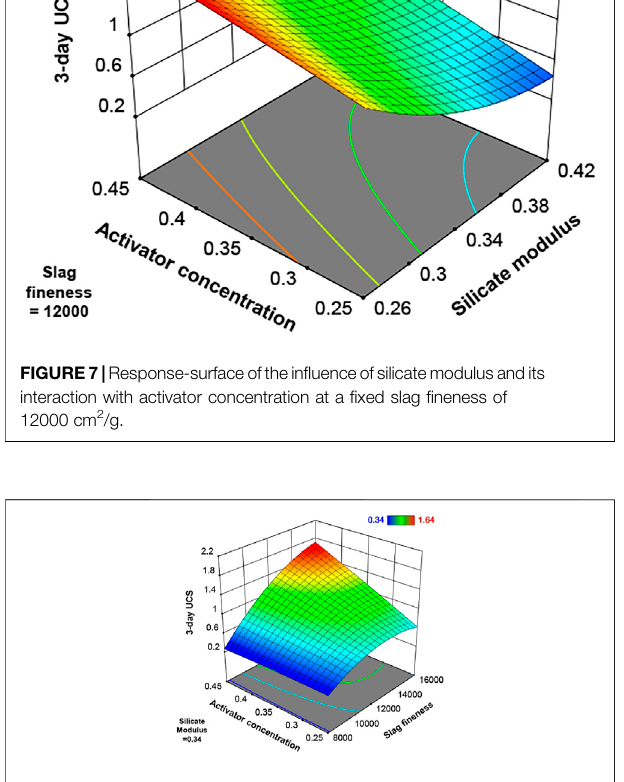
Frontiers in Materials |